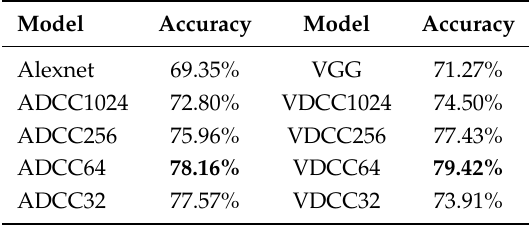
Table 3. Retrieval accuracies of the models based on Alexnet, VGG and corresponding DCC frameworks according to the P@100 values.